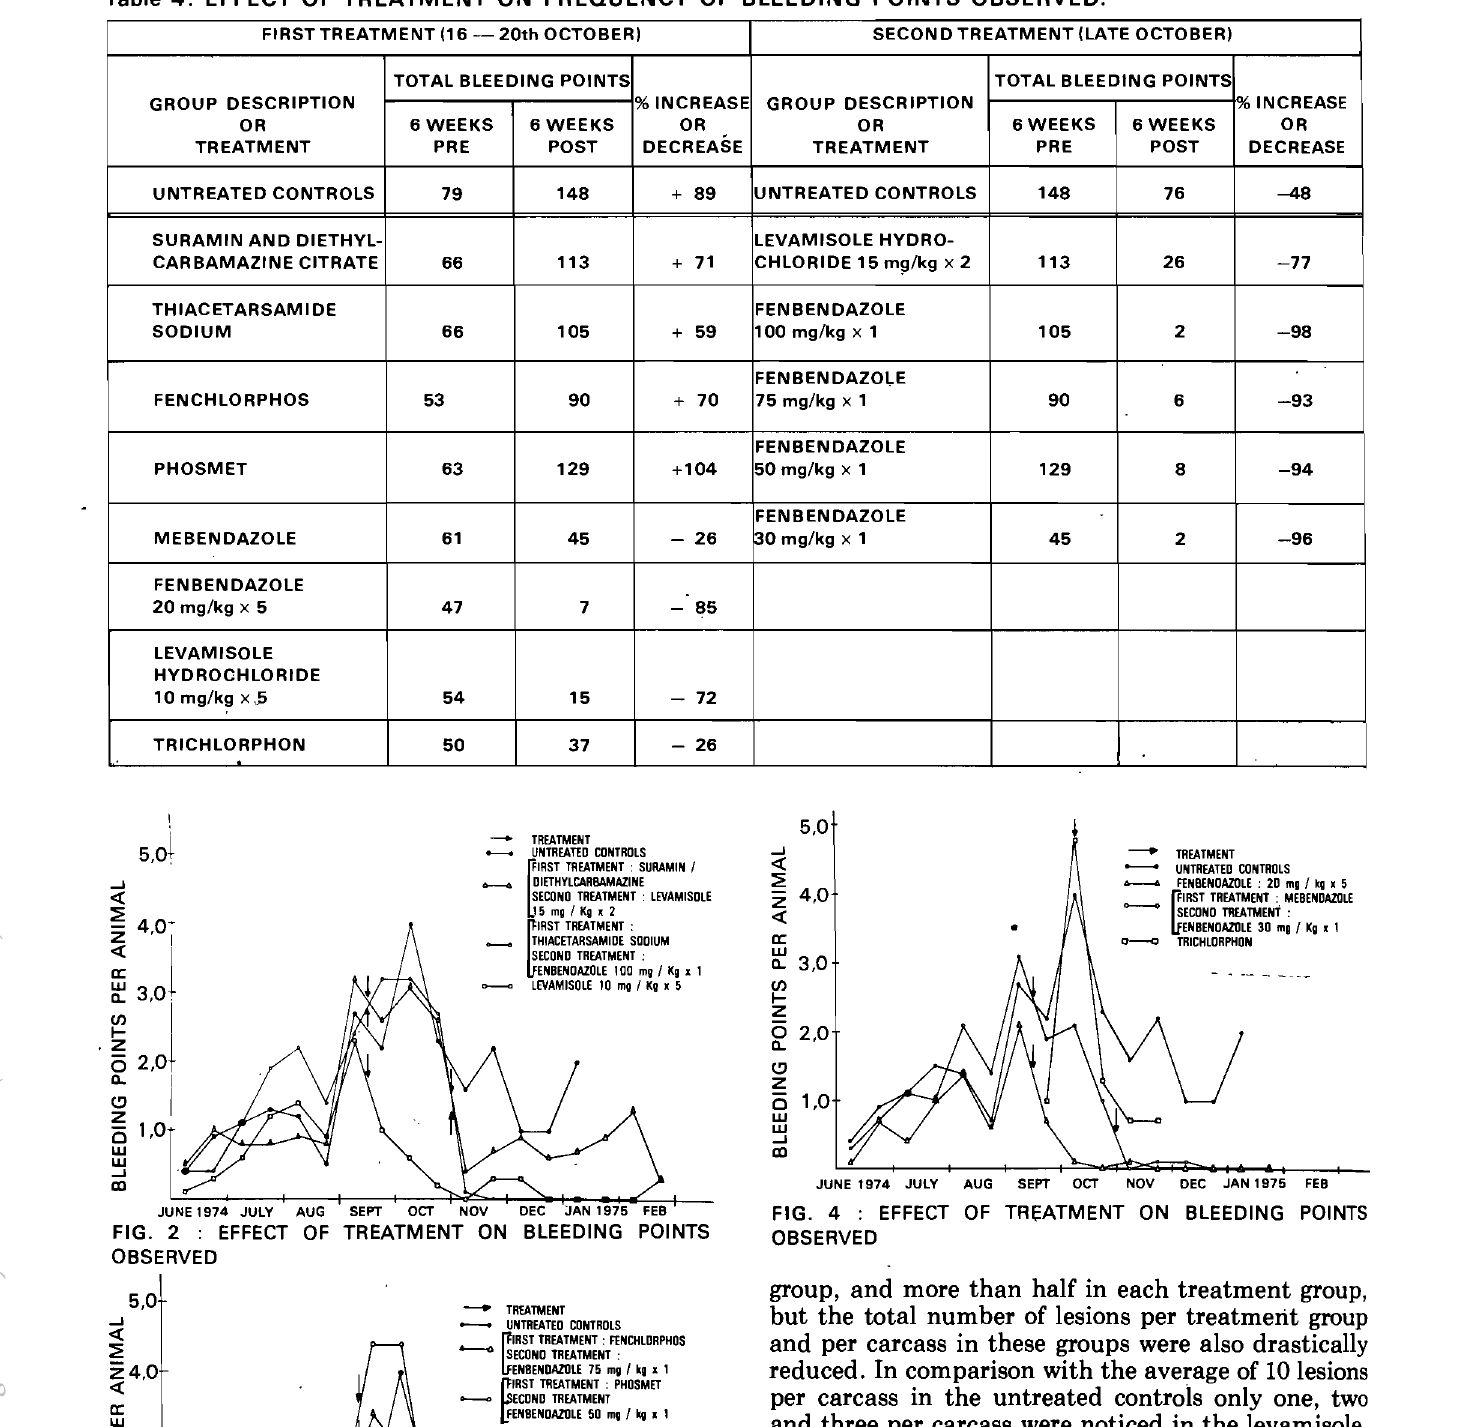
fenbendazole groups